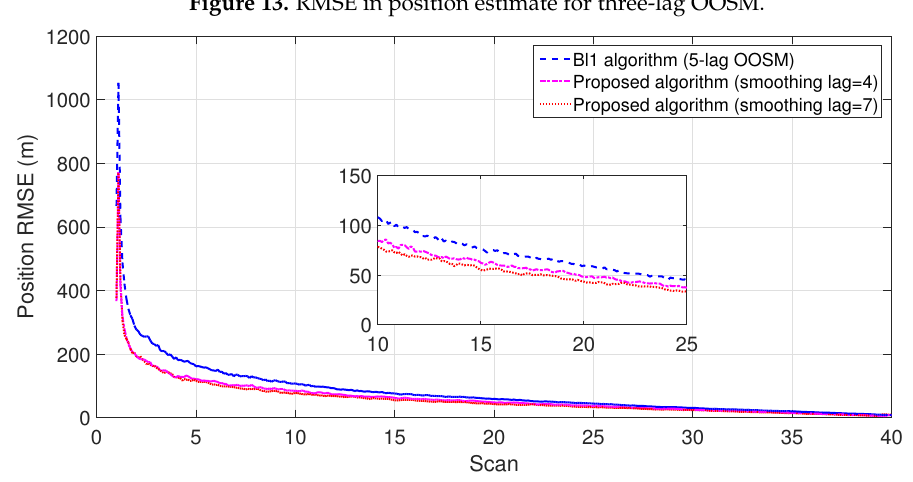
Figure 13. RMSE in position estimate for three-lag OOSM.